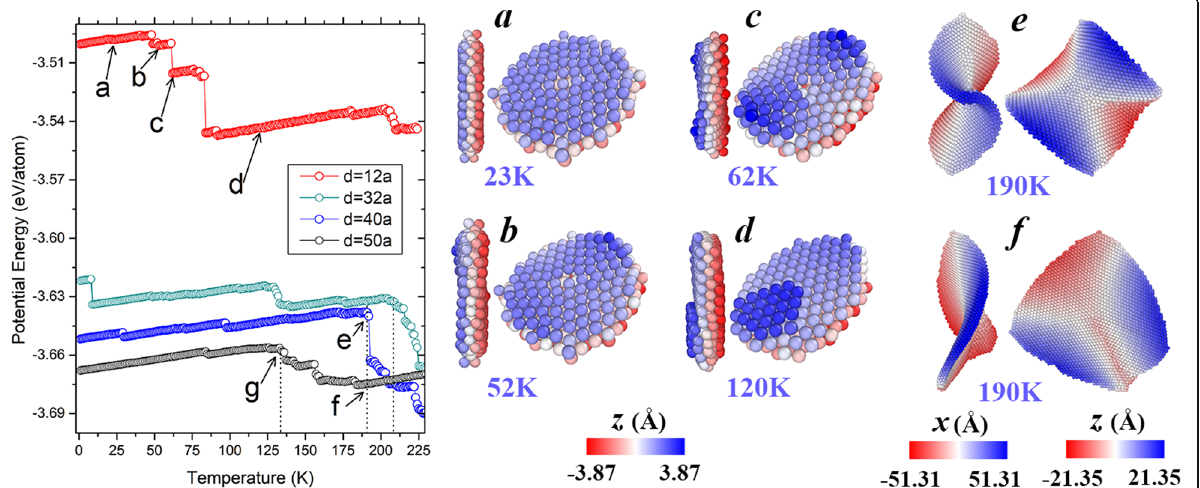
Fig. 5 Left panel: Temperature evolutions of potential energies of bcc Fe (001) nanoplates with different diameters. Right panel: Snapshots of the nanoplate with d = 12 a at a 23 K, b 52 K, c 62 K, and d 120 K; Snapshots of the nanoplate with e d = 40 a at 190 K and (f) d = 50 a at 190